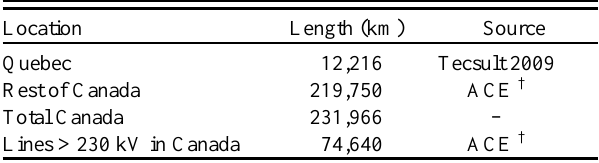
Table 1 . Length of transmission lines in Quebec and Canada.